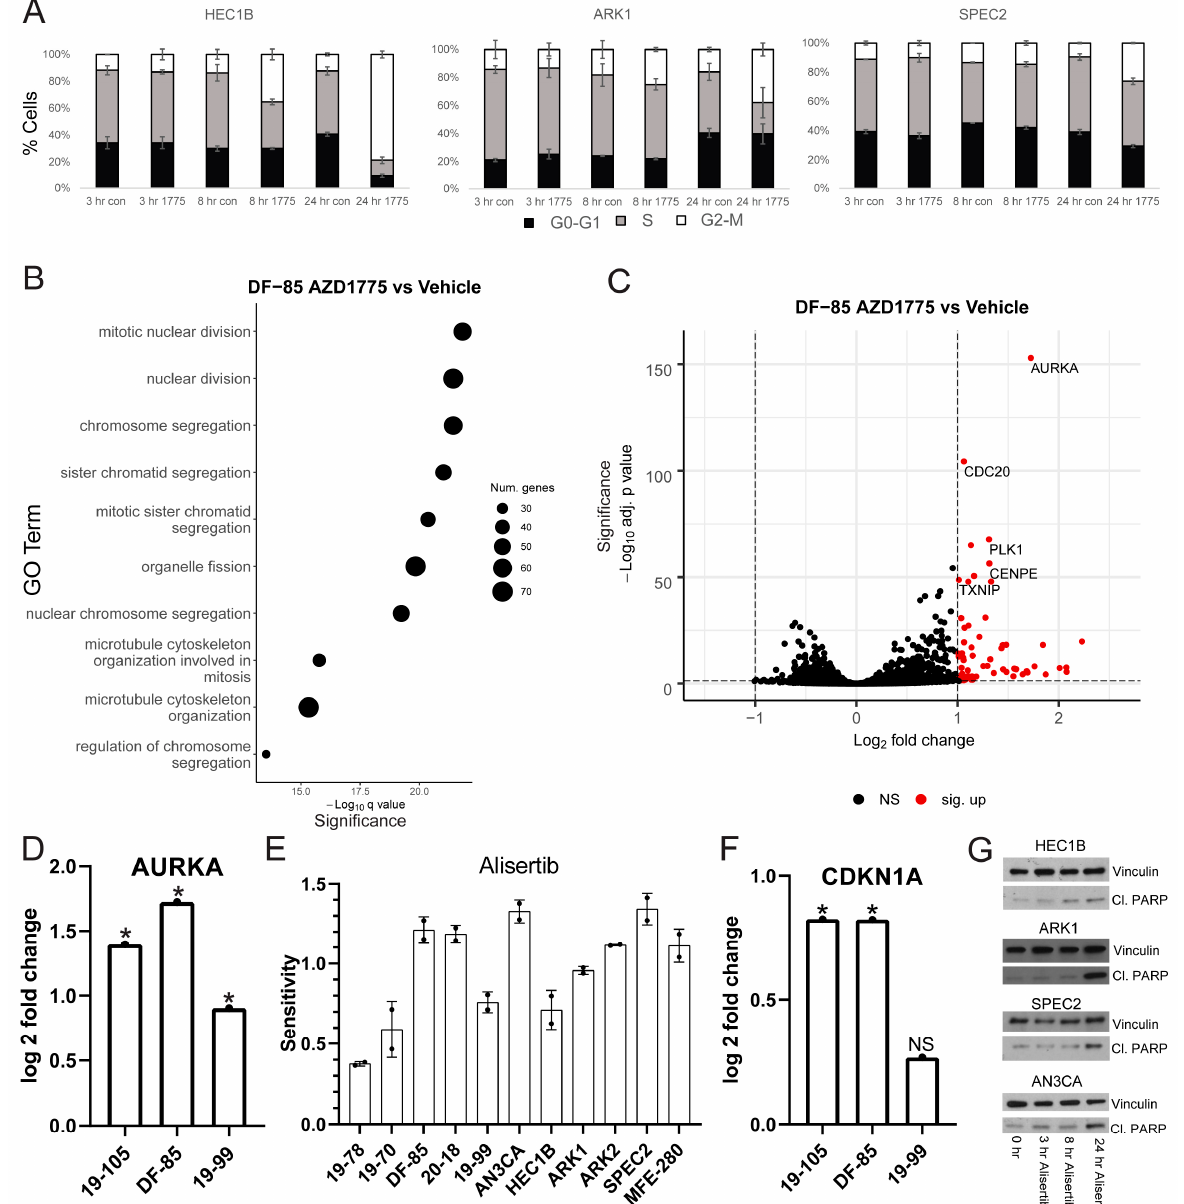
Figure 2. WEE1 inhibition induces significant AURKA upregulation in AZD1775 sensitive uterine carcinoma models, unmasking a strong vulnerability of TP53 mutant uterine carcinomas to Aurora kinase inhibition. ( A ) BrdU/propidium iodide cell cycle flow cytometry analysis was performed on a subset of cell lines at various timepoints after vehicle (con) or 0.5 uM AZD1775 (1775) treatment. The bars show different phases of the cell cycle (white G2-M, gray S, black G0-G1), and error bars represent standard deviation between two to three replicates. ( B ) Bulk RNA sequencing analysis of the treated organoids compared to the untreated set revealed significant enrichment for genes related to G2/M after GO overrepresentation analysis. In the graph, GO terms are listed on the Y -axis, circles represent the number of genes in the GO term group, and the X -axis represents increasing significance. ( C , D ) One of the most significantly upregulated genes in each organoid line post-AZD1775 treatment was AURKA , as shown in the volcano plot for DF-85 treated vs. vehicle in C and the log2 fold change bar graph in each line in D. For the volcano plot in C, p -values of increasing significance are shown on the Y -axis and increasing log2 fold change is shown on the X -axis. A black circle indicates genes with non-significant (NS)